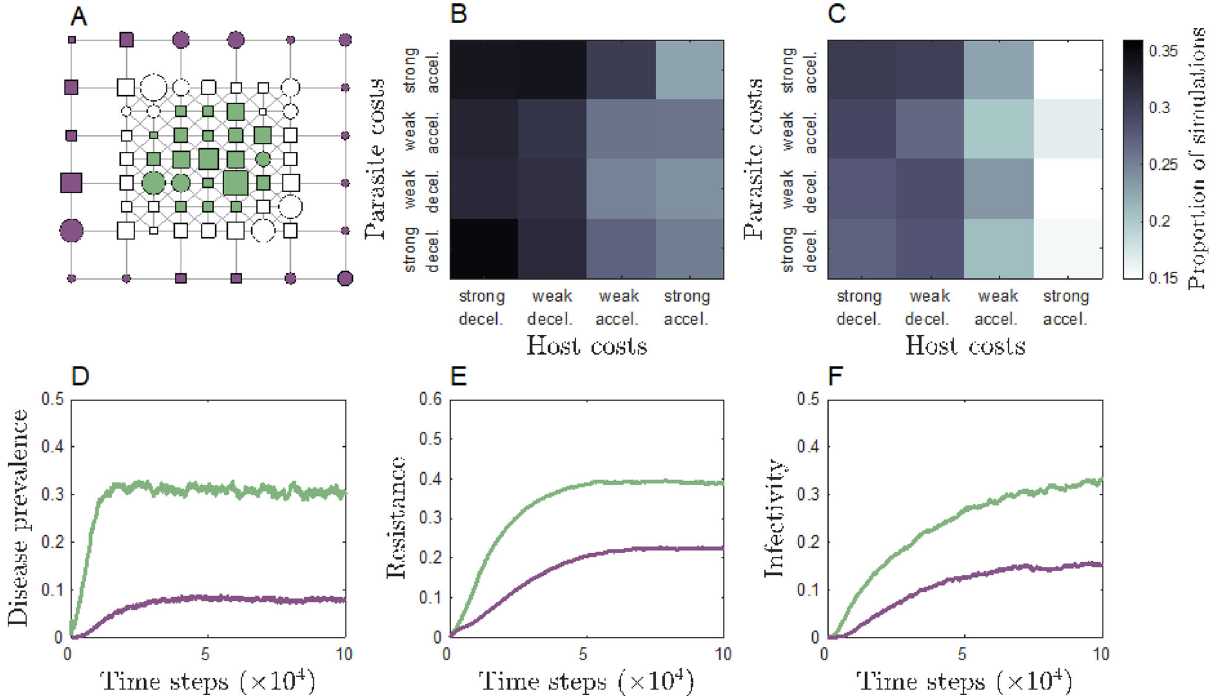
Fig.3|Metapopulationsimulationresults.A Examplesnapshotofthesimulation dynamics at t =10,000 across a metapopulation with assortative connectivity, highlighting well (green) and poorly (purple) connected populations (unshaded populations are neither well nor poorly connected) that are currently infected (squares) and uninfected (circles).The size of each node corresponds to the mean resistance of the local population. Proportion of simulations which qualitatively match the empirical results as the shape of the host and pathogen cost functions are varied for transient ( B ) and long-term ( C ) dynamics: (strong decel.